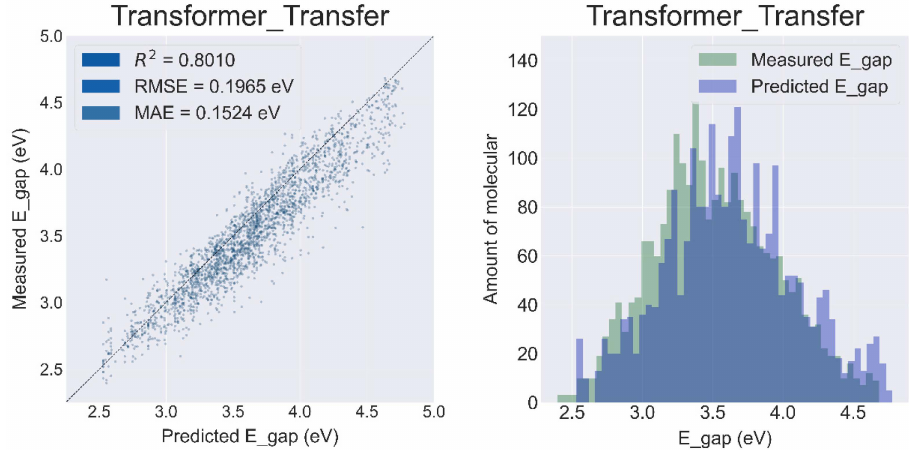
Figure 5. Results of the prediction sets for the Transformer Model with transfer learning.